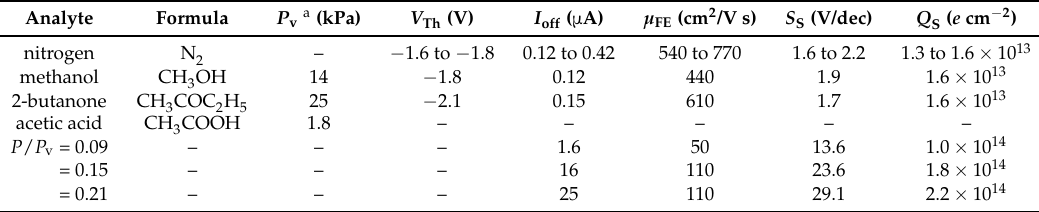
Table 1. Summary of analyte properties and FET transport parameters while exposed to the analyte. Analyte